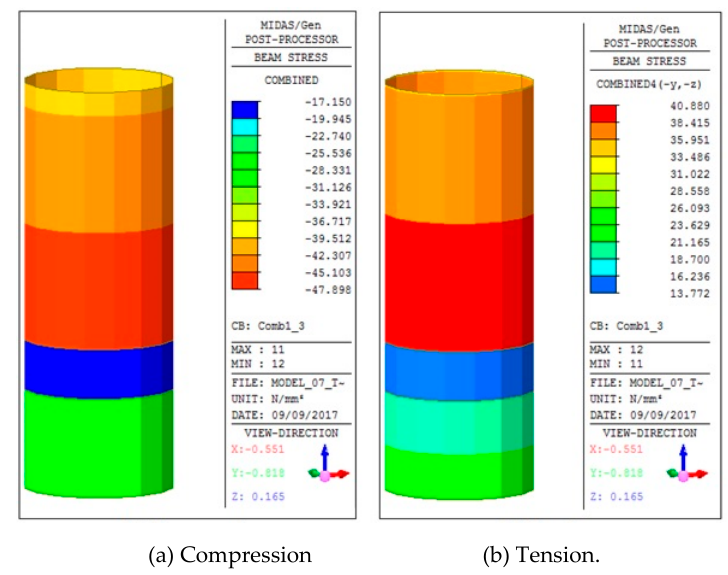
Figure 9. Stress distributions of steel shaft on DLC6.2da3.